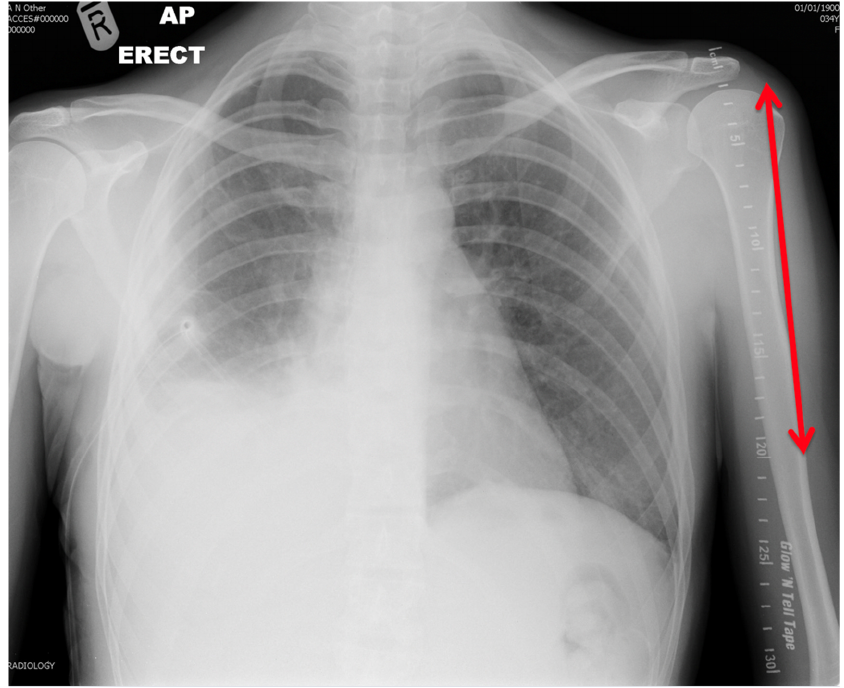
Figure 3. Radiograph demonstrating radio-opaque marker parallel to left humerus.